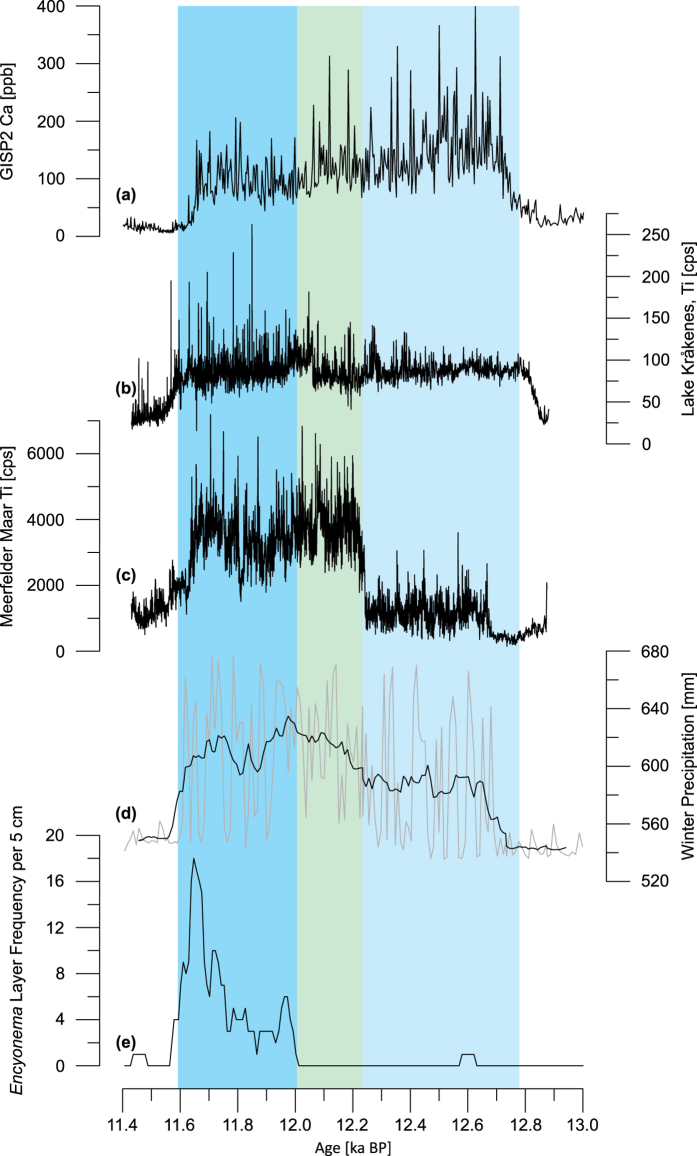
Comparison of (a) Greenland GISP2 dust record11 (represented by Ca), (b) Ti record from Lake Kråkenes5 and (c) Ti record from MFM9 with (d,e) results from the study presented here; each plotted on their respective chronologies except (a) which is on the GICC05 time scale36; background colours are with reference to Lake Suigetsu: light blue marks the first phase of the YDS, light green the transition interval and blue the second phase of the YDS.